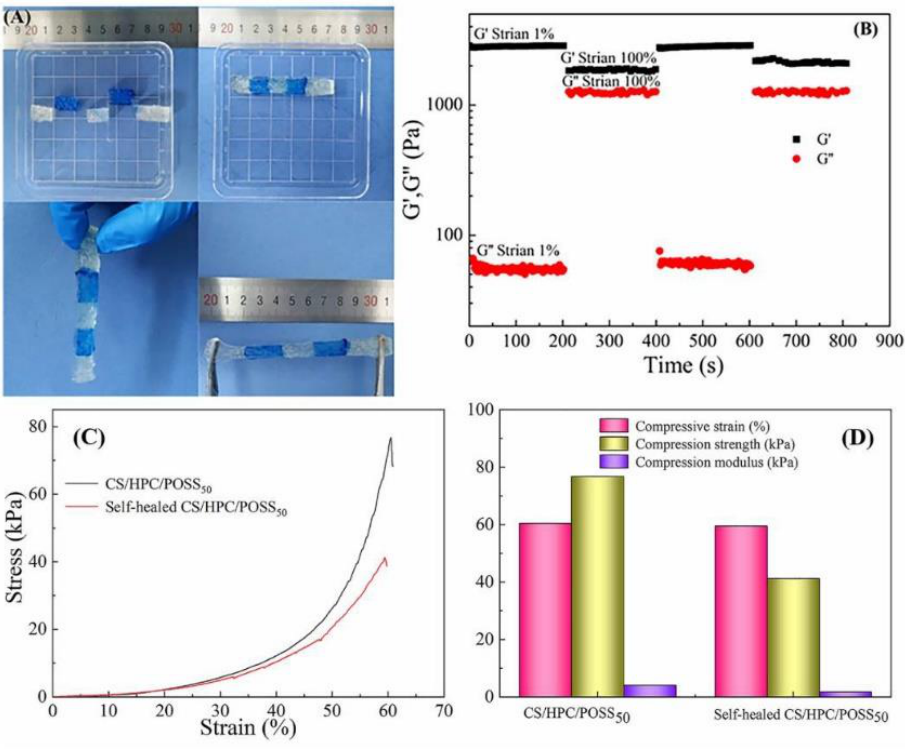
Figure 32. Self-healing performance ( A ) and continuous step strain measurements ( B ) of CS/HPC/POSS 40 hydrogel; Mechanical properties and results of compression tests on the original and self-healed CS/HPC/POSS 50 hydrogel ( C , D ). Reprinted from Reactive & Funct. Polym . 2021, 158 , Zhang, X.; Meng, Y.; Shen, W.; Dou, J.; Liu, R.; Jin, Q.; Fang, S., pH-responsive injectable polysac- charide hydrogels with self-healing, enhanced mechanical properties based on POSS, 104773, [102] Copyright (2021), with permission from Elsevier. Copyright (2021), with permission from